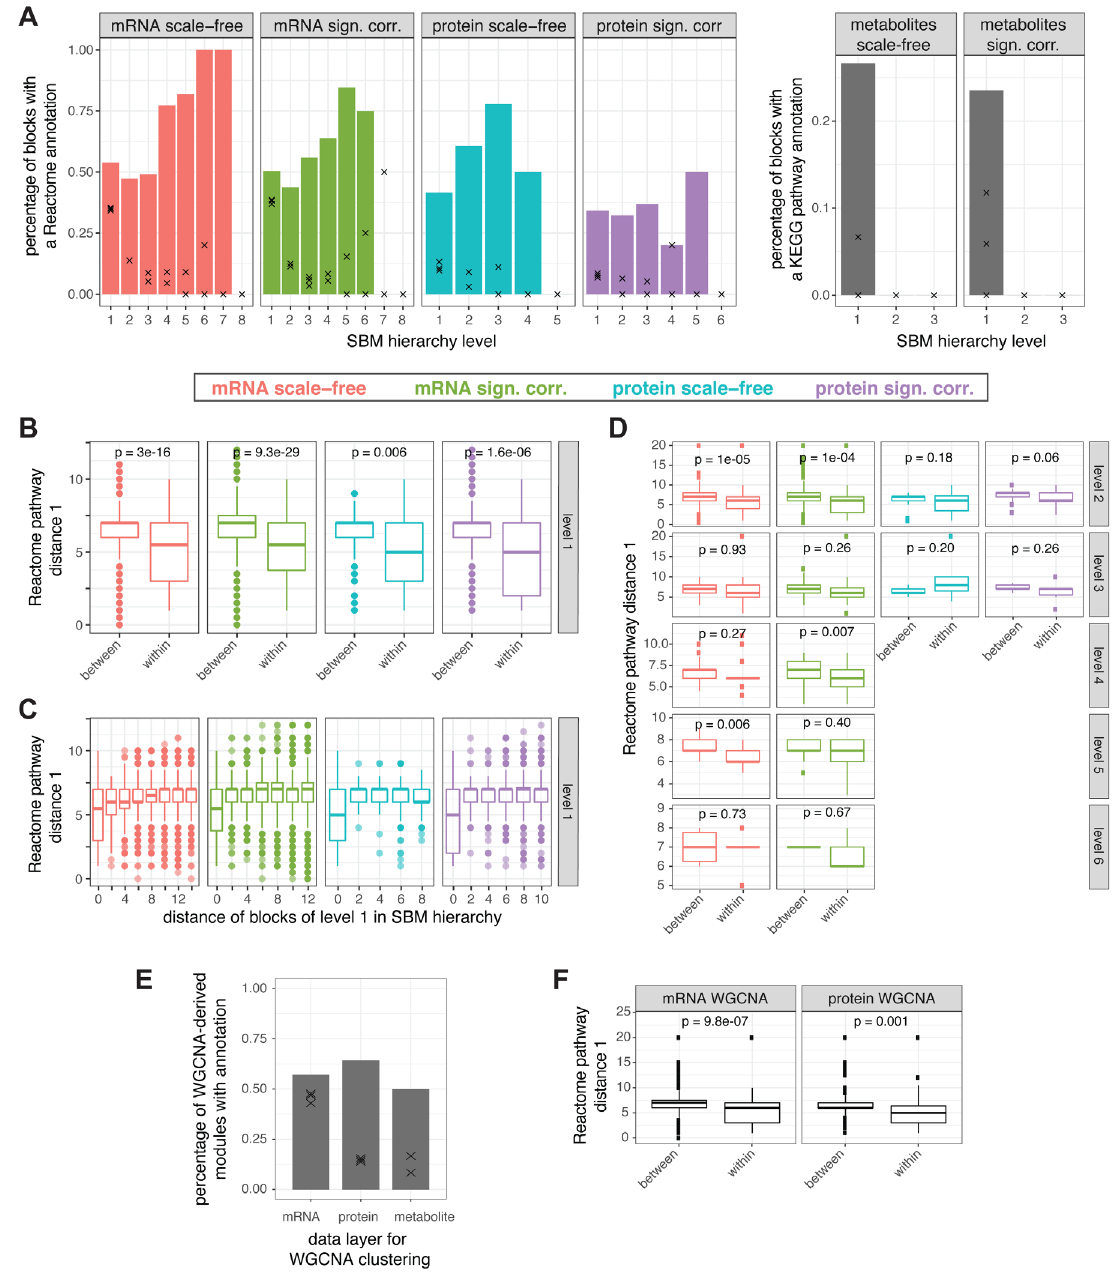
Figure 3. Modules derived from hierarchical SBM represent biological function. ( A ) Percentage of blocks with at least one overrepresented Reactome (KEGG) pathway for the best fitting SBM (see Figure 2B) for the mRNA and protein (metabolite) networks, reduced by condition on scale-freeness (scale-free) or on significance of correlation (sign. corr.), for each hierarchical level (bars). Black crosses denote the percentages of blocks with at least one overrepresented Reactome (KEGG) pathway for three SBMs each with exactly the same structures but randomly shuffled mRNAs or proteins (metabolites). ( B ) For the lowest hierarchy level clustering (level 1) of each of the four mRNA and protein SBMs, we calculated the average distances between every pair of Reactome pathways between blocks and those within blocks, for a distance measures (i) based on the Reactome hierarchy (see Figure S3 46 for the results using the alternative distance measure (ii)). The lower the distances the more similar are the pathways. The pathways associated to one single block (within) are significantly more similar than those associated to different blocks (Welch’s t-test p-value < 0.01) suggesting that biological functions are consistent within blocks and distinct between blocks. ( C ) Distance of Reactome pathways (as in B ) between blocks (or within blocks, for distance of blocks in SBM being zero) versus the distance of the blocks in the SBM hierarchy for blocks on level 1. We do not find evidence that the Reactome hierarchy is reflected in the SBM hierarchy. ( D ) Between-module vs. within-module distances of Reactome terms as in ( B ) for blocks of SBM hierarchy levels 2-6. ( E ) Percentage of modules detected by the WGCNA approach with at least one overrepresented Reactome or KEGG pathway. Black crosses denote the results for three similar clusterings with randomly shuffled mRNAs, proteins, or metabolites. ( F ) Between- module vs. within module distances of Reactome terms as in ( B ) for the clusterings predicted from WGCNA-based module detection. Page 12